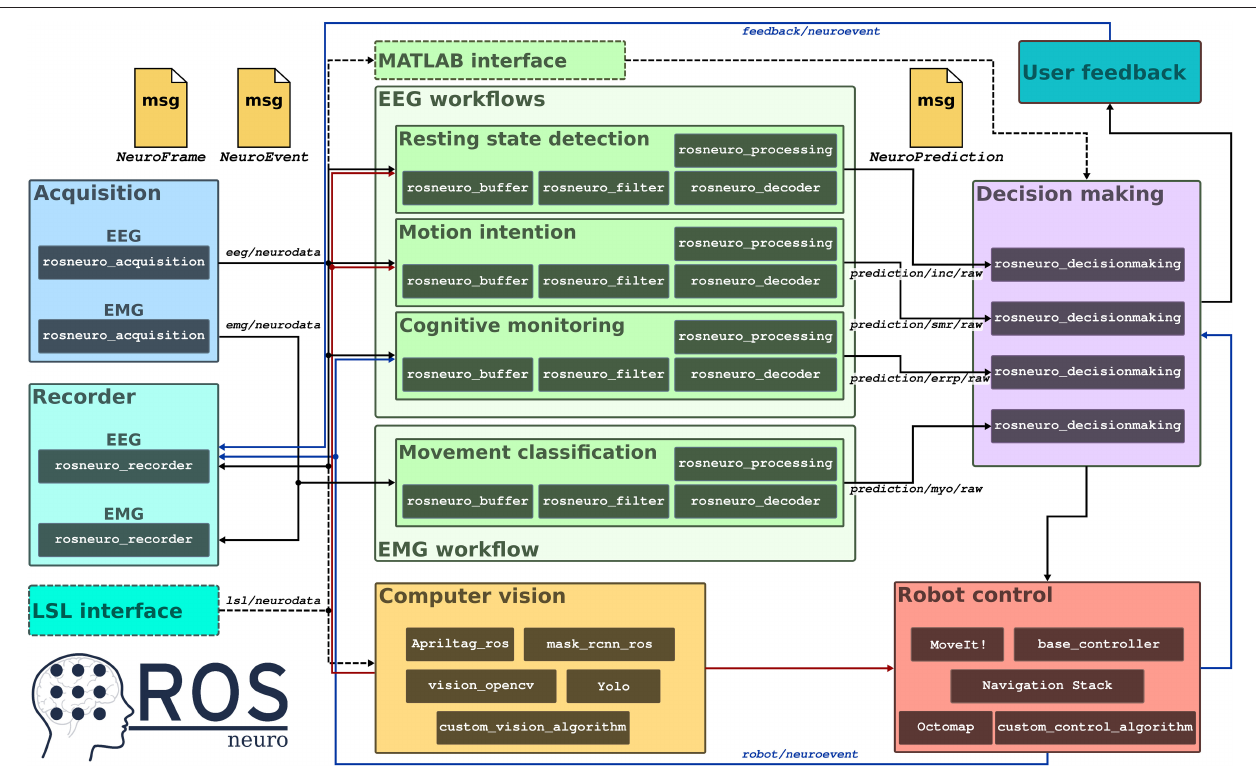
FIGURE 1 | A schematic representation of a hybrid, multi-process implementation of a neural interface with Robot Operating System (ROS)-Neuro. Two acquisition systems are used in parallel to acquire (and record) EEG and EMG data (blue and cyan boxes). An additional interface can be added to record the data stream from the LSL device (dashed cyan box). Data is made available in the eeg/neurodata and emg/neurodata communication channels as NeuroFrame messages to all the other modules. In the example, four different workflows work in parallel (green boxes) to detect resting state, motion intention, to monitor the behavior of the system from EEG signals, and to classify residual muscular activity from EMG data. An additional processing module can be added by exploiting the ROS-Neuro MATLAB interface (dashed green box). The output of the processing workflows is published as NeuroPrediction messages in the prediction/*/raw . A decision making module (purple box) reads the predicted outputs and generates a proper control signal for the robotic device. Such a signal can be also used to provide feedback to the user. In parallel, computer vision algorithms and ROS navigation packages (red and yellow boxes) not only take care of controlling the robot but also provide environmental information for the EEG workflows (red and blue